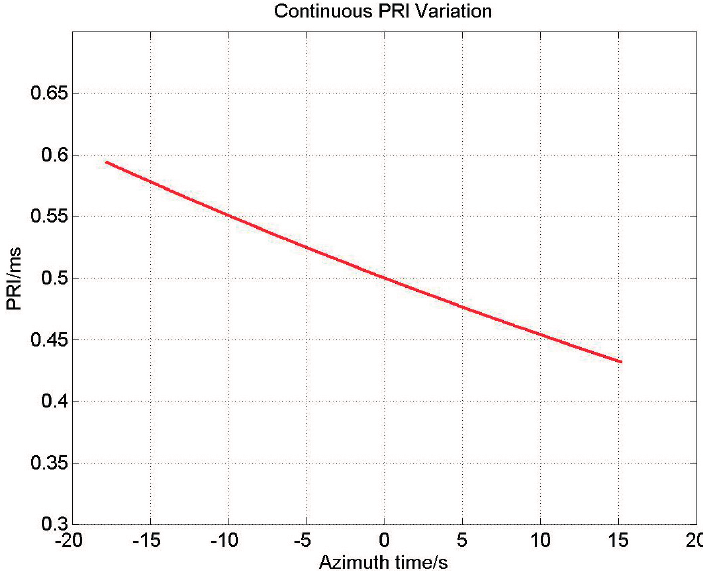
Figure 4. PRI variation with respect to the azimuth